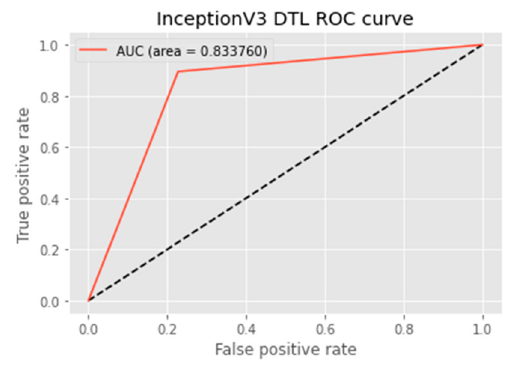
Figure 15. ROC curve of the InceptionV3 model.